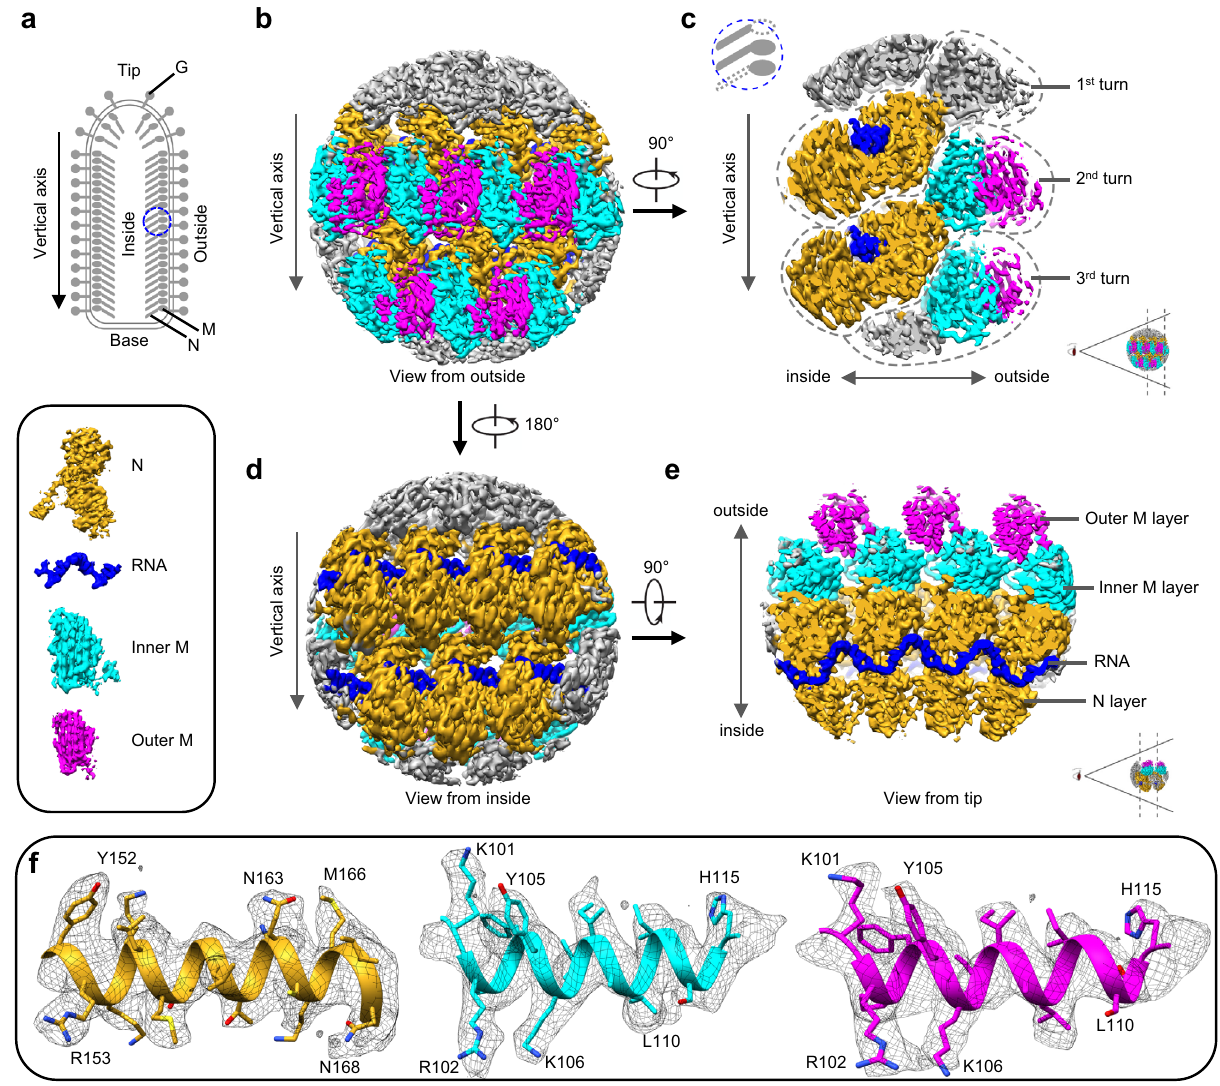
Fig. 1 | Sub-particle reconstruction of VSV trunk at near-atomic resolution. a Schematic diagram of the VSV virion. Blue circle marks the region used for sub- particle reconstruction. b , d CryoEM density maps of partial VSV nucleocapsid shown in two opposite views. Only intact N, intact M and RNA are colored for